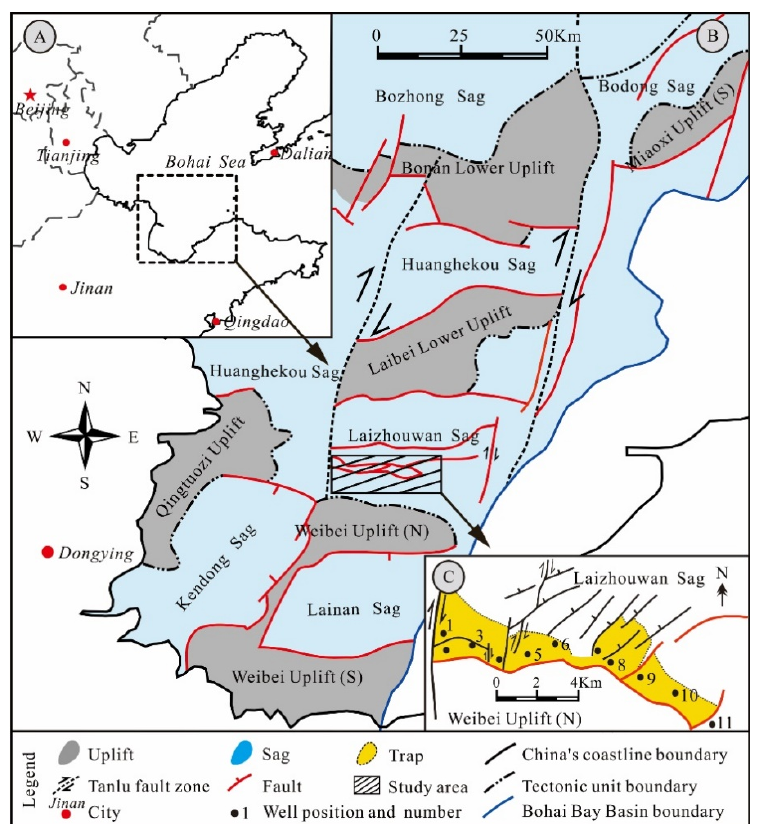
Figure 1. Geographic location structural map. ( A ) Location of the Bohai Sea, China; ( B ) Location of the Laizhouwan Sag; ( C ) Well locations of sampling area.